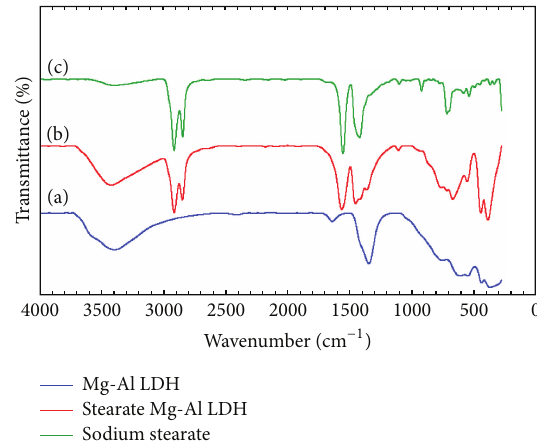
Figure 1: FTIR spectra for (a) pristine Mg-Al LDH, (b) stearate Mg- Al LDH, and (c) sodium